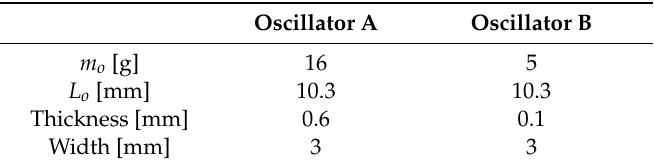
Figure 7. Effect of the tuning devices on the open-circuit frequency response function (FRF). The simple harvester shows the resonance peak at 123.9 Hz with an amplitude of 2.3 V/(ms − 2 ), the amplitude of 𝐹𝑅𝐹 (cid:3049) (cid:3290)(cid:3278) (𝜔) in the range of bicycle vibrations is negligible. The addition of a tip